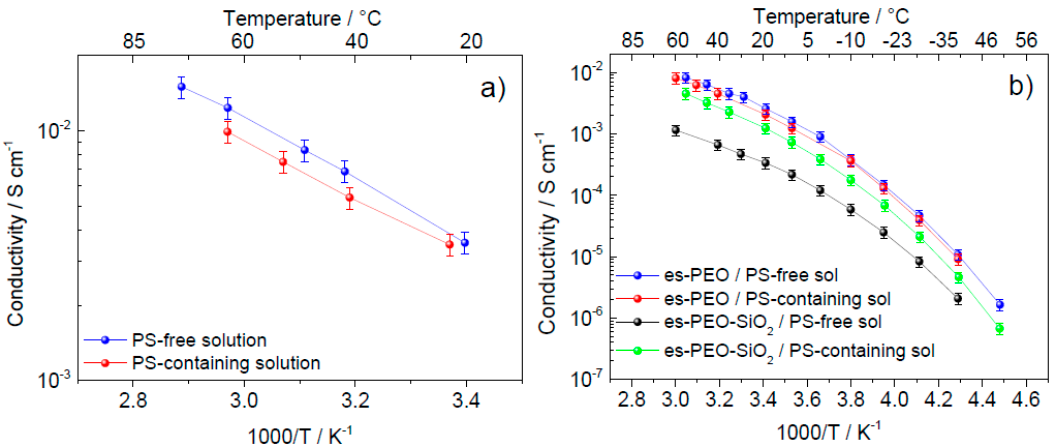
Figure 5. Arrhenius plots of conductivity of the swelling liquid solution ( a ) and of the gelled electrolyte membranes ( b ). Table 2. Conductivity values extrapolated at 25 ◦ C and 50 ◦ C for the gelled electrolyte membranes.